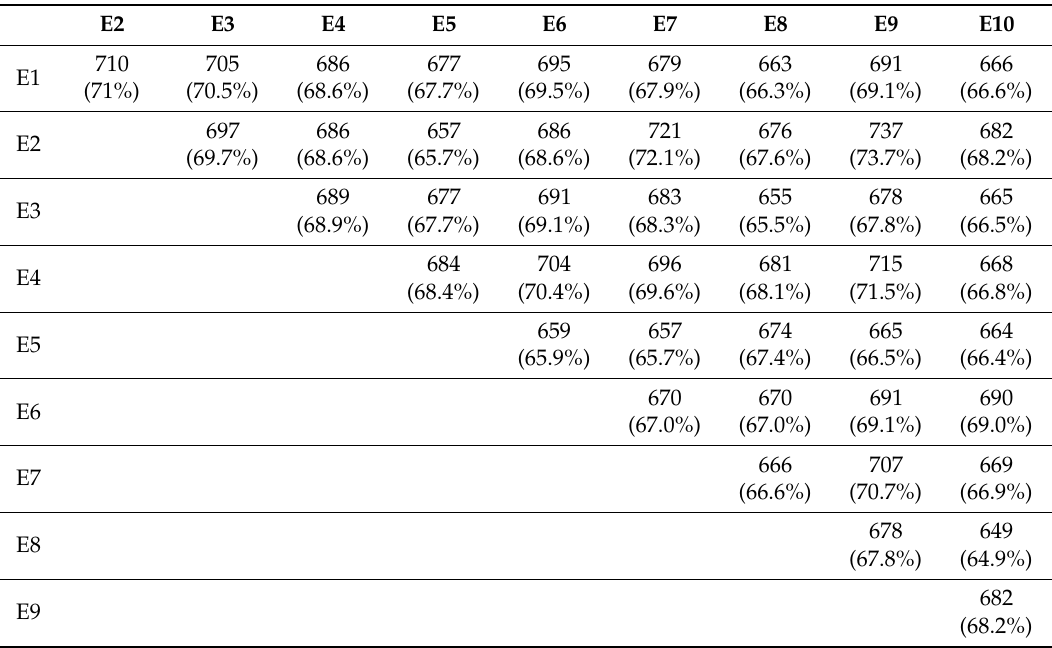
Table 3. The number of overlapped genes between the top 1000 genes of any two ranked lists obtained by ECGUFS.